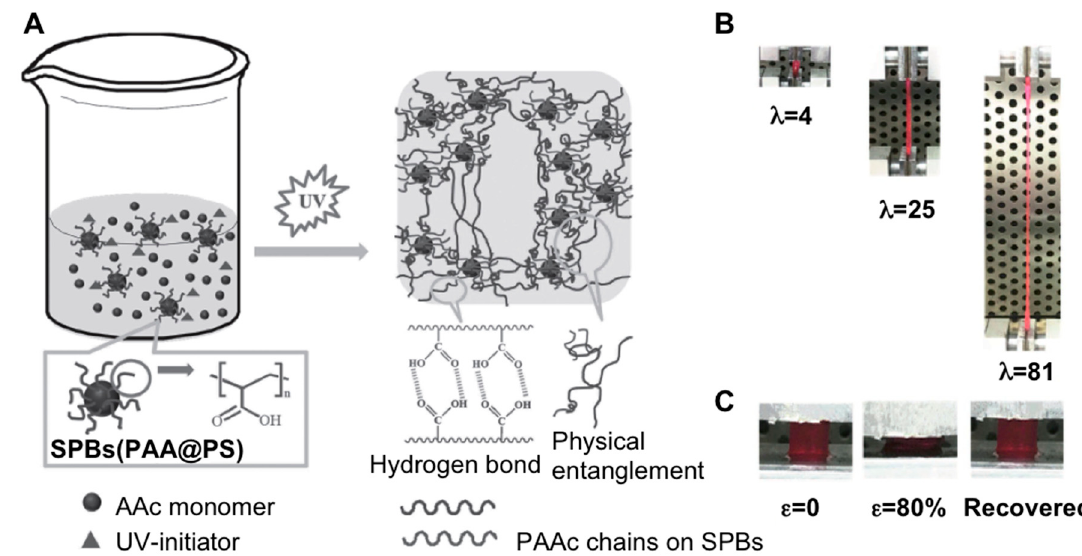
Figure 12. ( A ) Schematic illustration of the synthesis of PAAc / PAAc@PS hydrogels. ( B ) Pictures of S 0.1 A 0.4 gels in tensile test. ( C ) Photographs of S 0.1 A 0.6 gels in compressive test. Nomenclature of hydrogels: S n A m , where n and m are the weight contents of PAAc@PS solution (0.1 wt.%) and PAAc in the hydrogel, respectively. Adapted with permission from Reference [66]. Copyright 2017 Wiley- VCH.